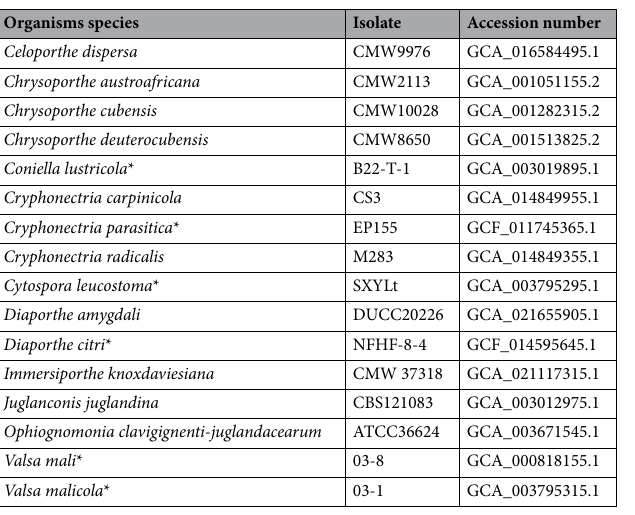
Table 2. List of Diaporthales isolates used for phylogenetics and comparative analysis. The annotation of the isolates indicated by an asterisk were already available on NCBI and were here used as models for the gene